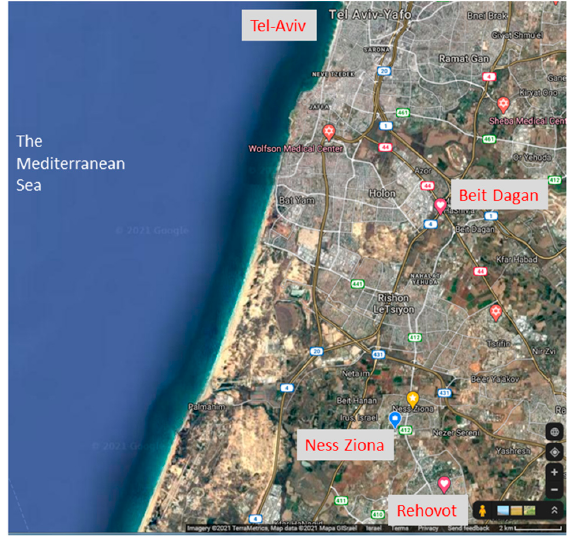
Figure 3. Field-experiment area map [Google] showing the measurement site in Ness Ziona and the meteorological stations nearby.